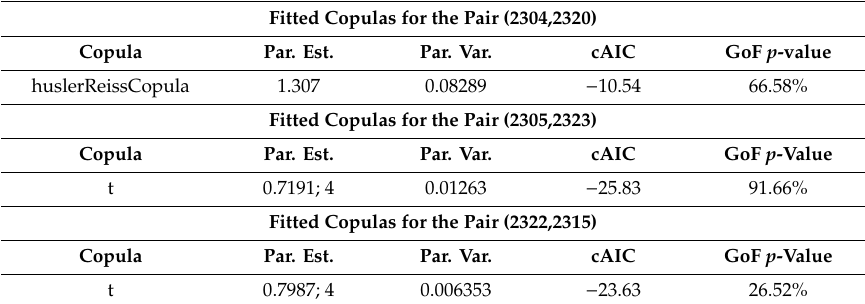
Table 4. Fitted copula families. Shown: the estimates of the parameters and the corresponding variances, the estimates of the corrected AIC, and the Goodness-of-Fit p -value.